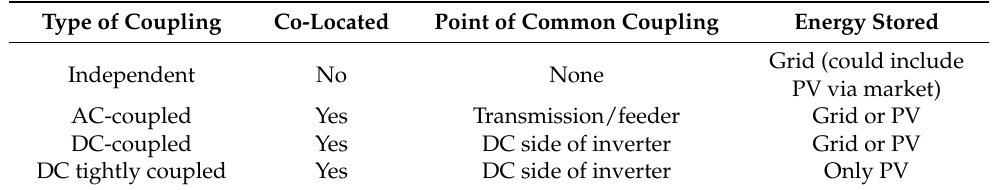
Table 1. PV Plus Storage